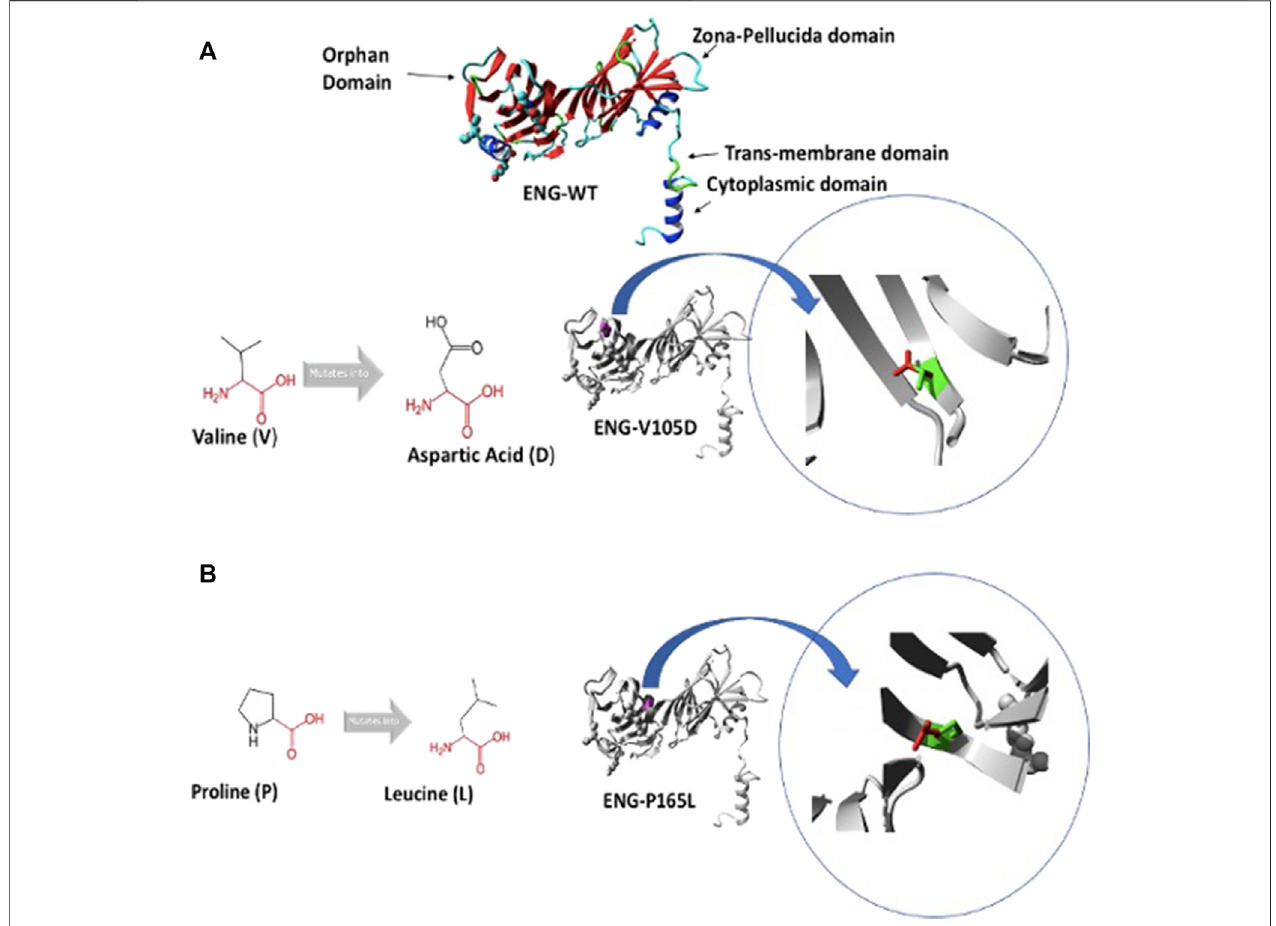
FIGURE 1 | Predicted structure of Endoglin WT and variants V105D and P165L. (A) shows 3D ribbon structure of Endoglin WT built by HOPE protein modelling program based on ahomologous structure. It shows mutation ofamino acid variants Valine (V) to Aspartic acid (D) (Both in black). Focus on mutation site: The protein is coloured grey, the side chains of both the wild type “ V ” and the mutant residue “ D ” are shown and coloured green and red respectively. (B) mutation of amino acid variants Proline (P) to Leucine (L) (Both in black). Focus on mutation site: The protein is coloured grey, the side chains of both the wild type “ P ” and the mutant residue “ L ” are shown and coloured green and red